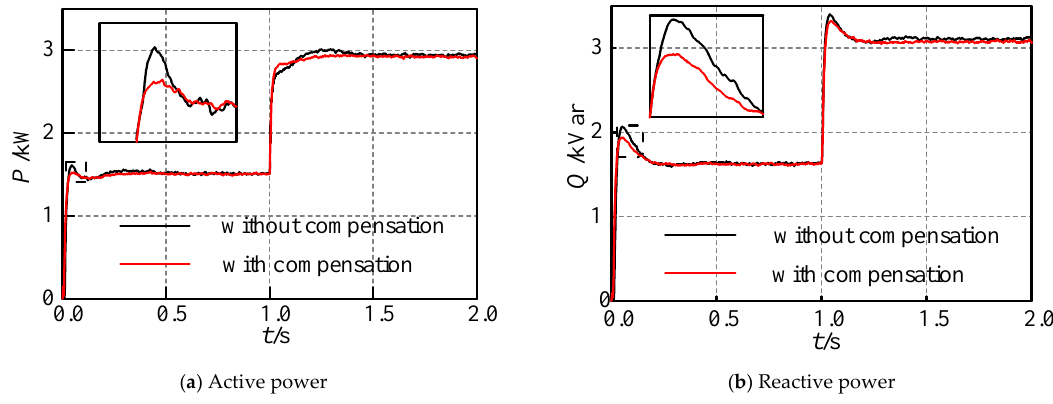
Figure 13. Comparison of power waveforms.